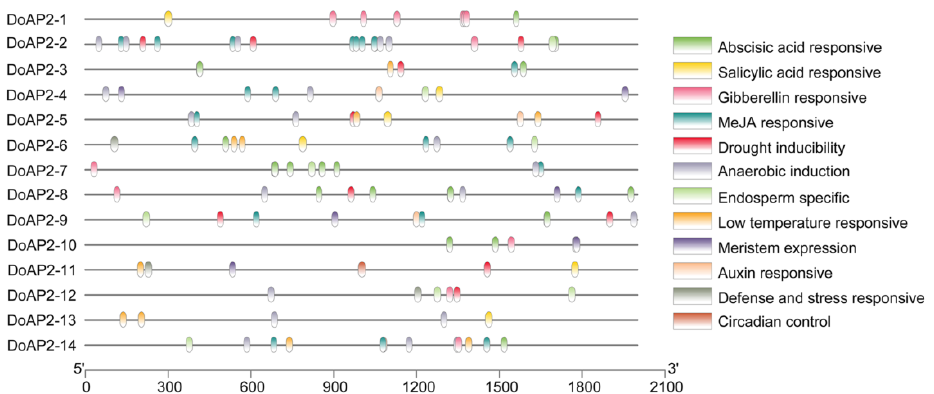
Figure 3. Prediction of cis -responsive elements in the 2-kbp upstream region of the initiation codon of 14 DoAP2 genes. Different colored boxes indicated different cis -responsive elements. MeJA, methyl jasmonate.